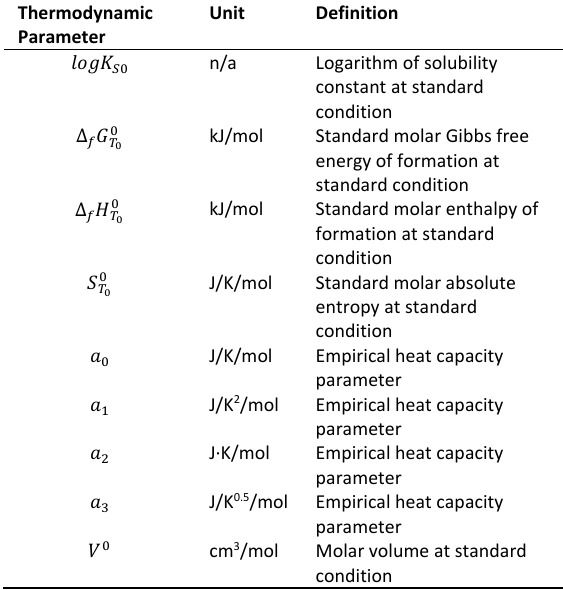
Table 1. List of required thermodynamic parameters of new solid reaction product. Thermodynamic